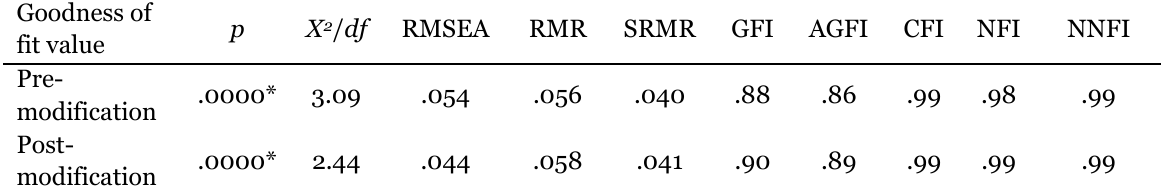
Results of Confirmatory Factor Analysis for the 8-Factor Construct of m-TASLM Goodness